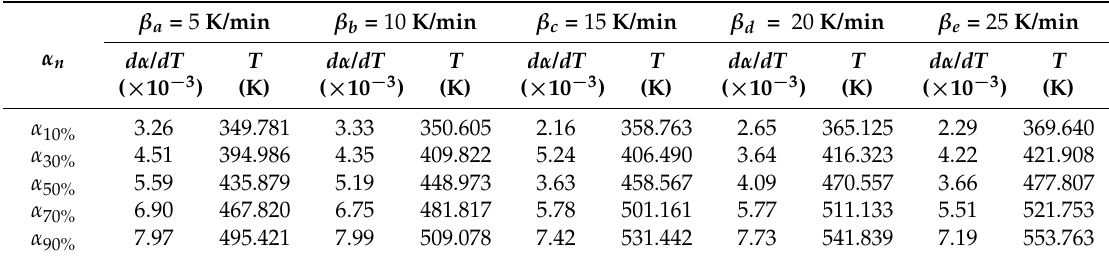
Table 4. Parameters for incineration kinetic modeling in Stage 1.